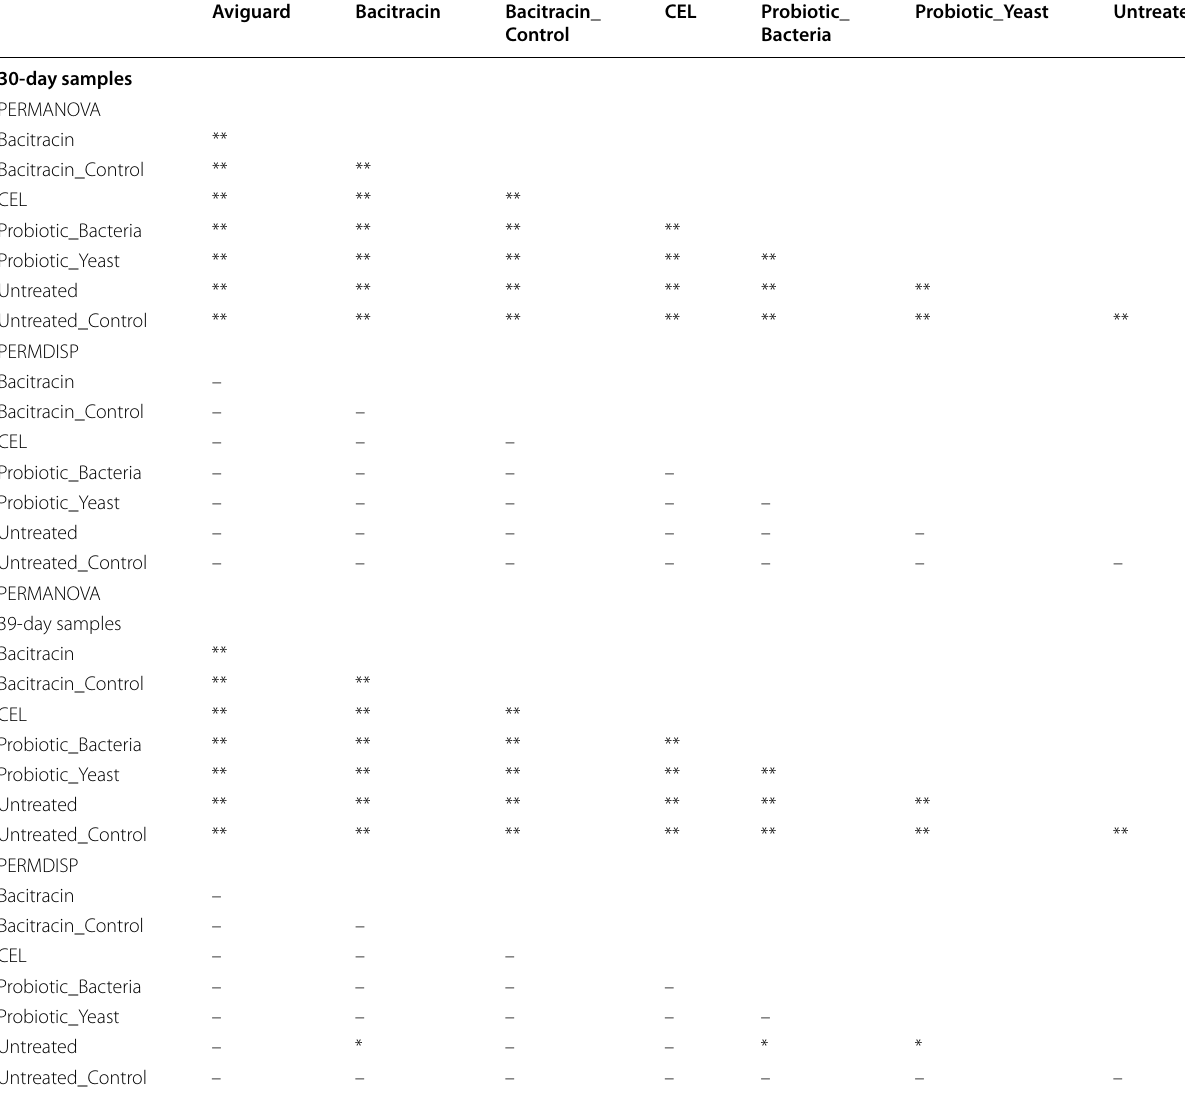
P values measured by pairwise PERMANOVA and PERMDISP tests of the Bray–Curtis distances conducted in parallel * p < 0.05; ** p < 0.01; *** p < 0.001